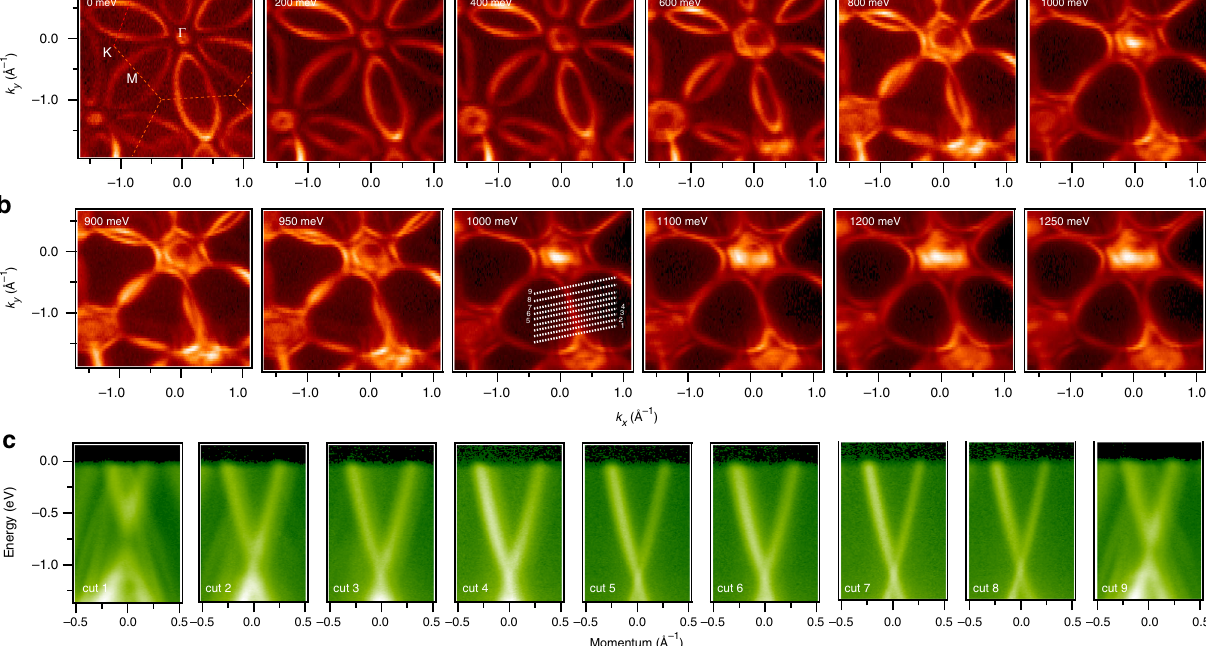
Fig. 3 Experimental observation of the Dirac node arc. a Constant energy contour plots at various binding energies. b Constant energy contour plots closer to the Dirac-node arc. Binding energies are given in the plots. c Dispersion map along the K – M – K direction along the cut directions indicated in the 1000- meV constant energy contour panel of b . All data were collected at the SIS-HRPES end station at the SLS, PSI at a photon energy of 100 eV with a temperature of 18 K